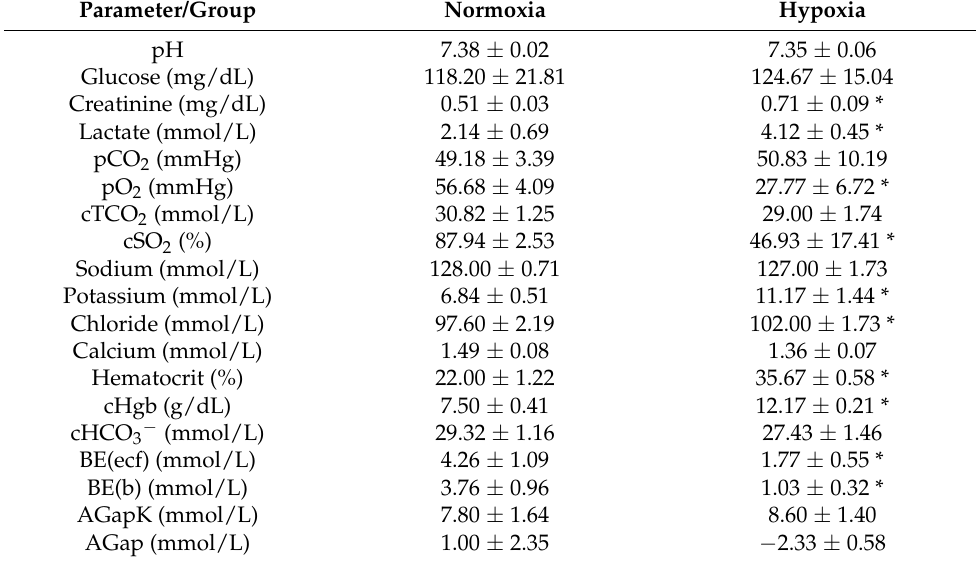
Table 1. Parameters of blood gas analysis.